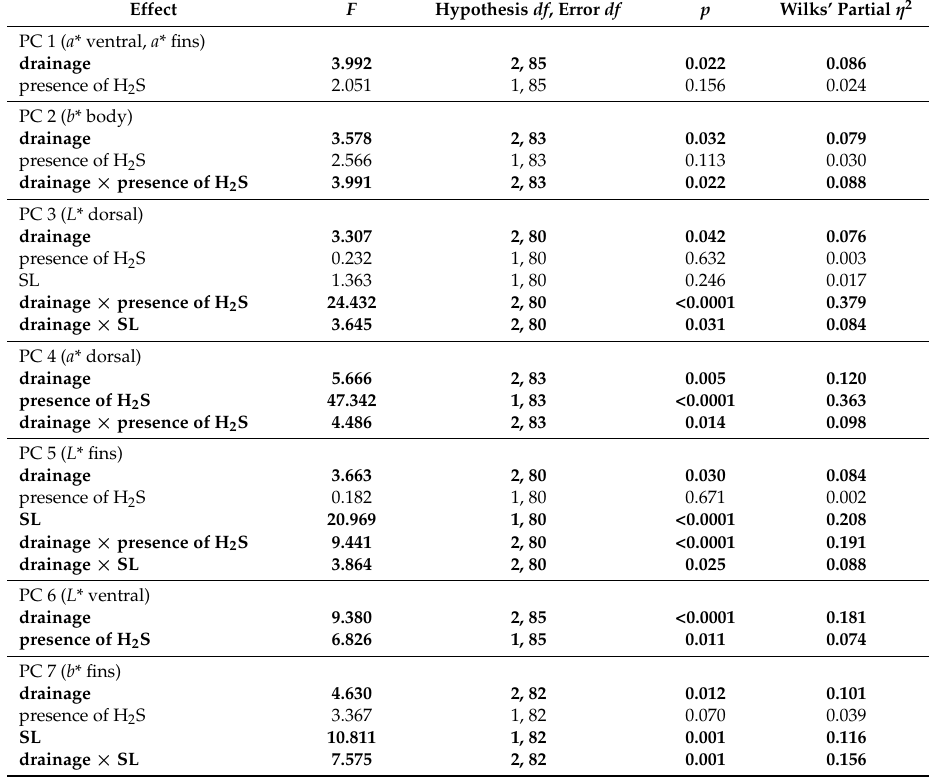
Table A3. Post hoc ANCOVAs for each PC separately. F -ratios and effect strengths (partial η 2 ) were approximated using Wilk’s λ . The statistically significant effects are highlighted in